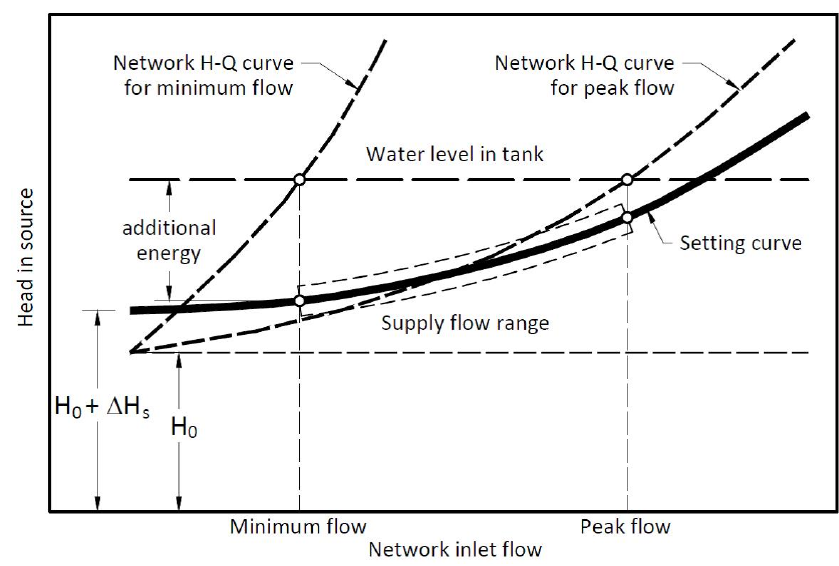
Figure 1. Representation of the network resistance and setting curves.